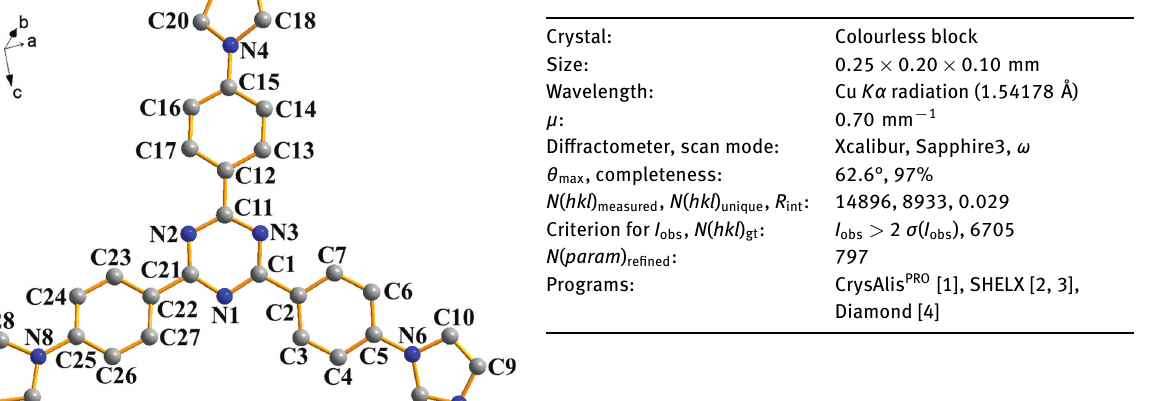
Table 2: Fractional atomic coordinates and isotropic or equivalent isotropic displacement parameters (Å 2